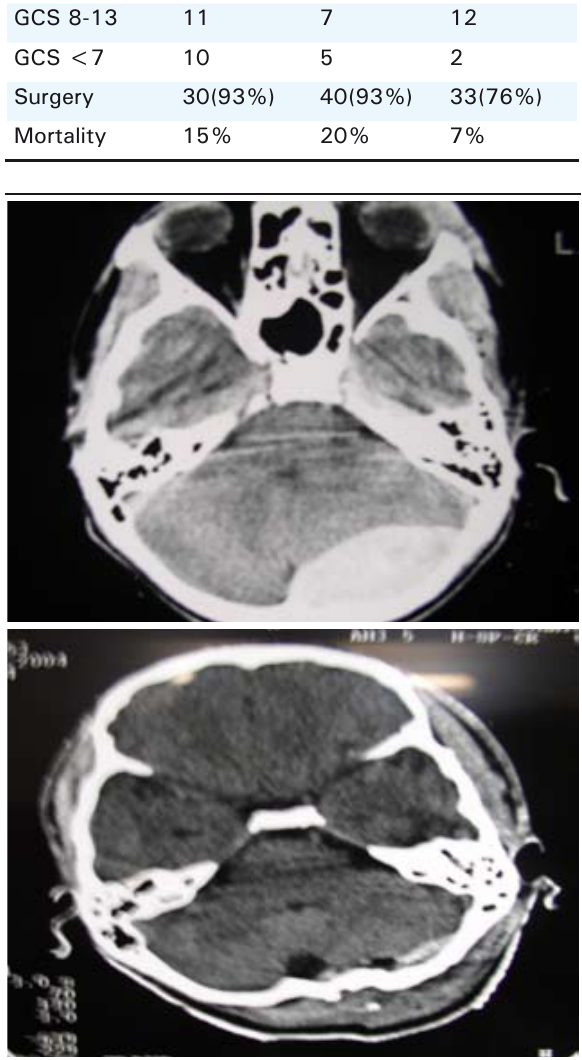
Figure 1. Pre and post operative CT